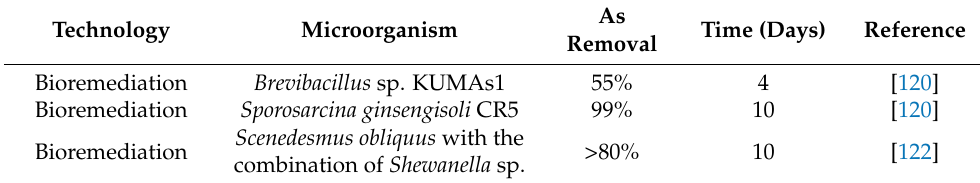
Table 6. Microbial agents used for arsenic